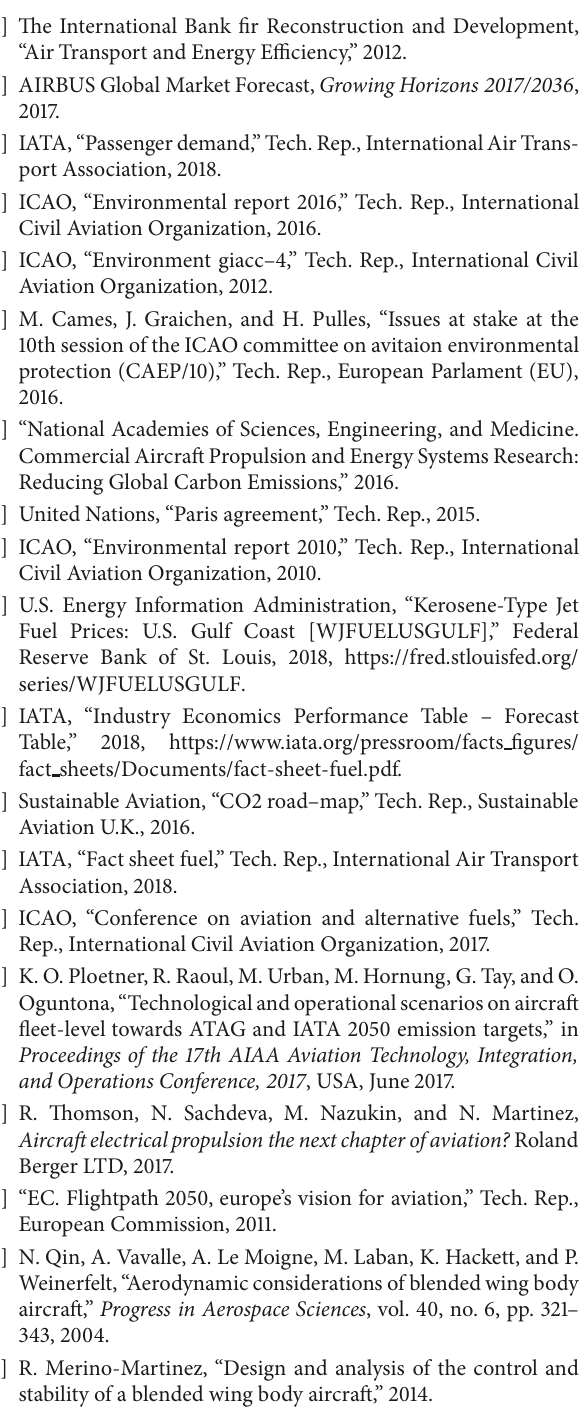
[11] IATA, “Industry Economics Performance Table – Forecast Table,” 2018, https://www.iata.org/pressroom/facts figures/ fact